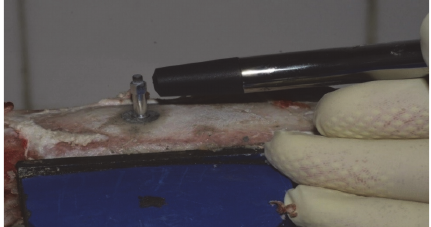
Figure 3: Insulation of smart peg on implant and measurement of ISQ value by Osstell